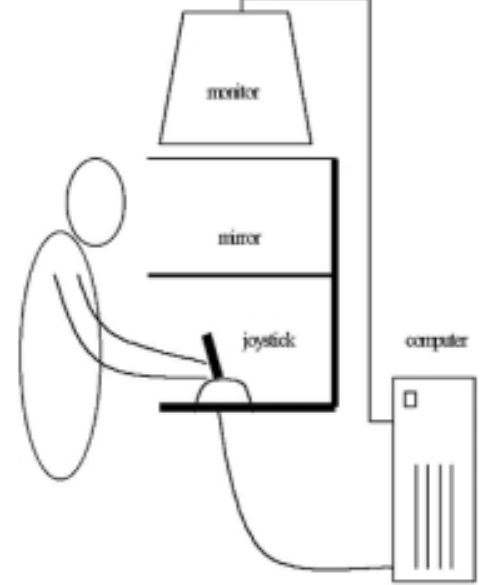
Fig. 1. Schema of the device. The participants sat comfortably in front of the apparatus with their forehead leaning on a foam cushion. A computer screen was placed face down on a metallic support. A horizontal mirror, located below the screen, reflected the image of the screen. A joystick was placed below the mirror on the table supporting the apparatus. The distance between the table and the mirror was 31 cm. The participants had to hold a joystick with their right hand and execute random movements with their elbow resting on the table. The movements of the joystick were fed into a virtual hand holding a joystick according to the real position of the joystick actually held by the participants. The virtual image was projected on amirroroverlying theparticipants’ hand. Thus,whenthe participants looked at the mirror, they saw the image of a virtual hand moving a joystick just above their own hand actually doing that. This design allowed the dynamic representation of the movements of the joystick held by the participants with an intrinsic delay inferior to 30 ms. The position of the participants’ forearm was regained and adjusted so as to coincide with the direction of the virtual forearm seen in the